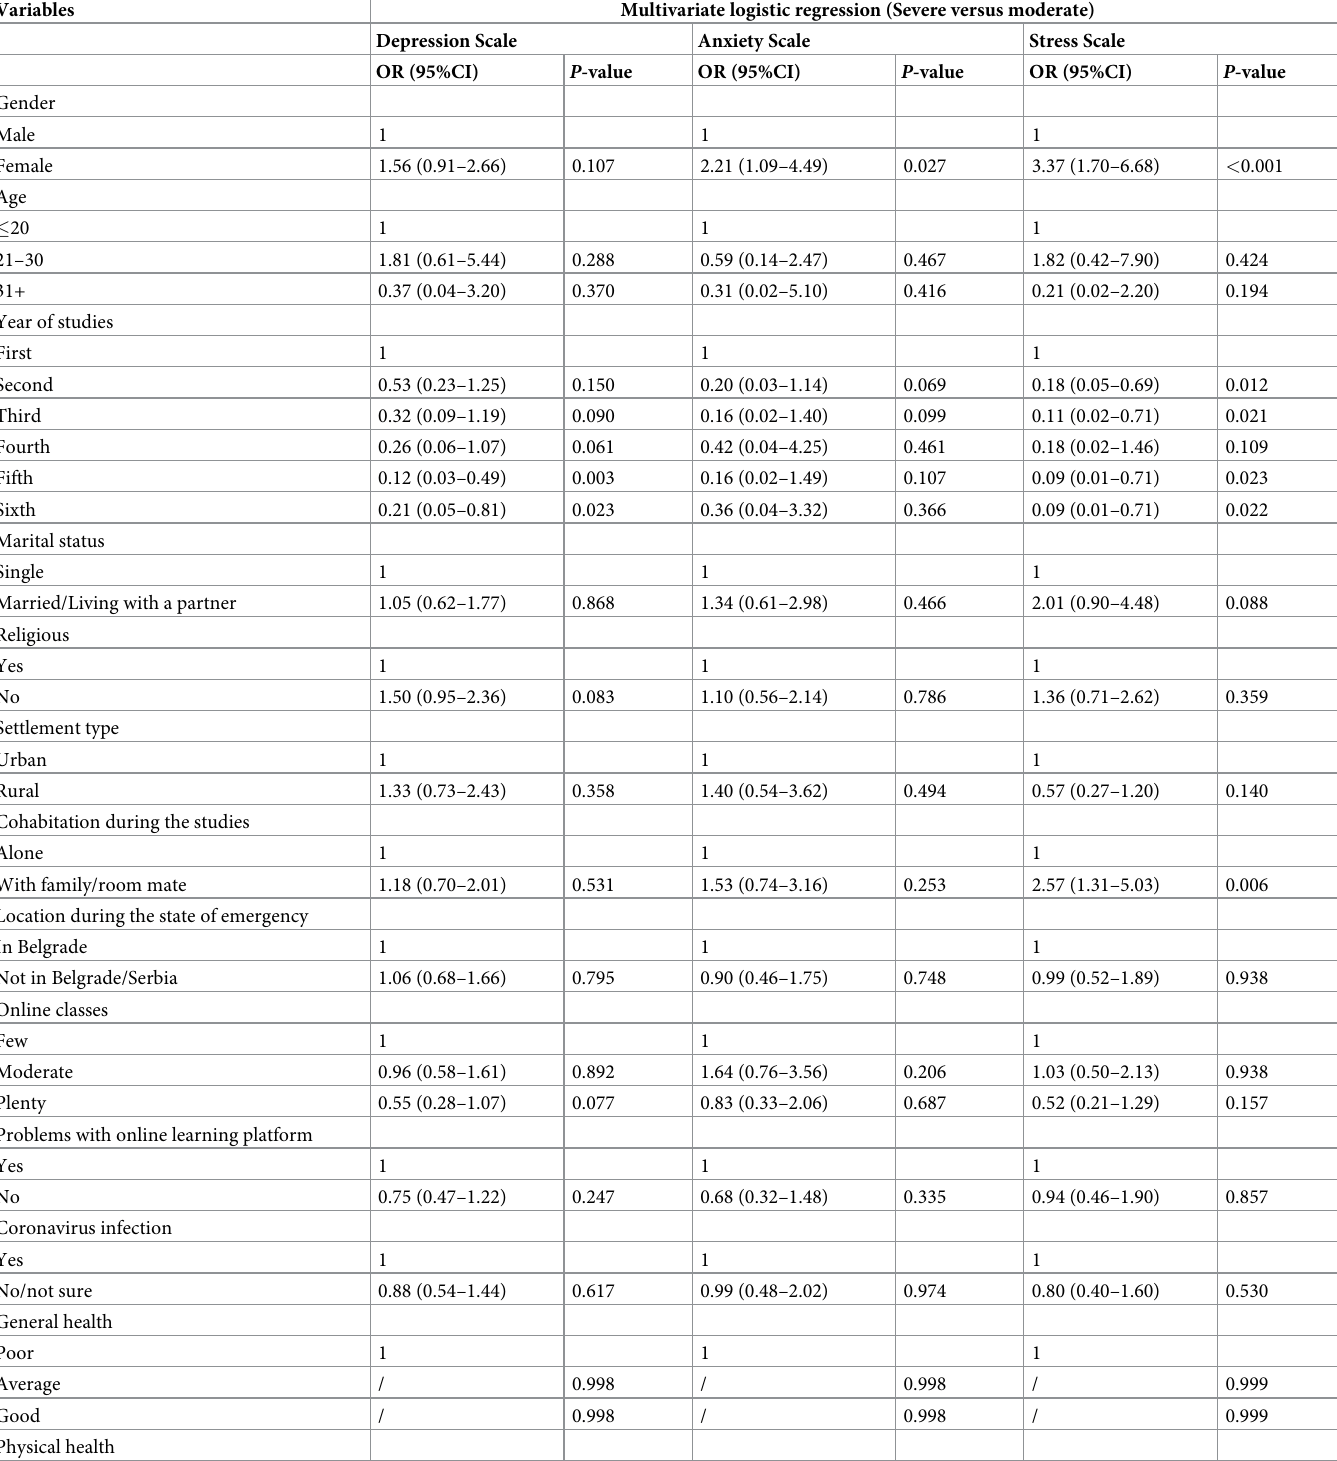
Table 4. Associations of scales of depression, anxiety and stress with students’ demographic variables, their medical studies and health status during the coronavi- rus pandemic–results of multivariate logistic